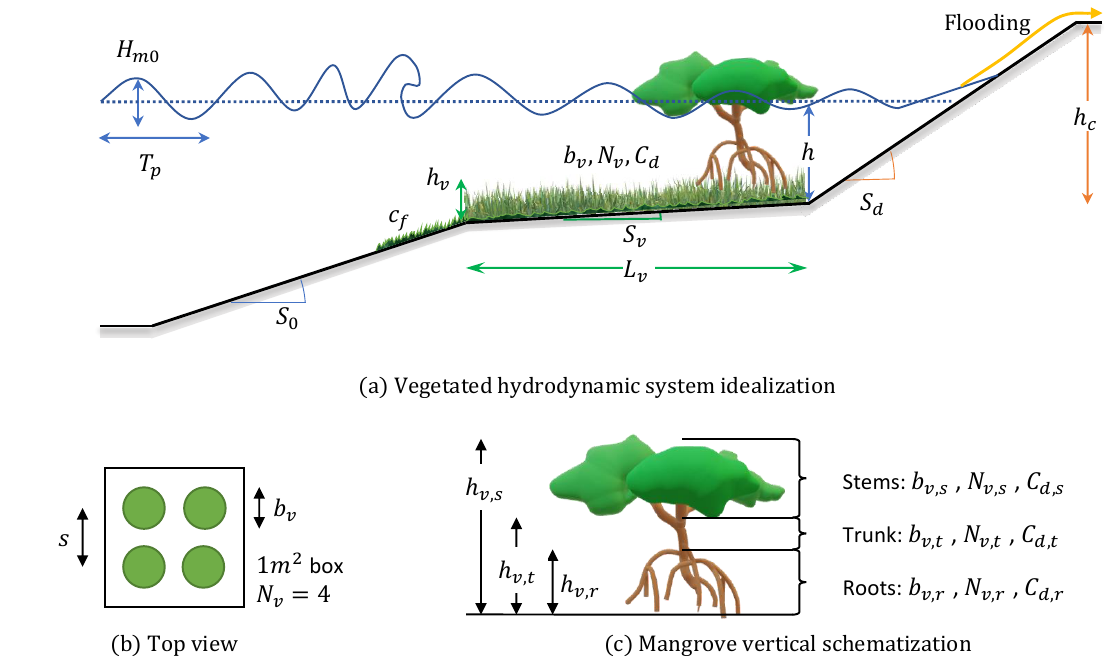
Figure 5. Idealized vegetated hydrodynamic system for stochastic modeling. See nomenclature in appendices for variables’